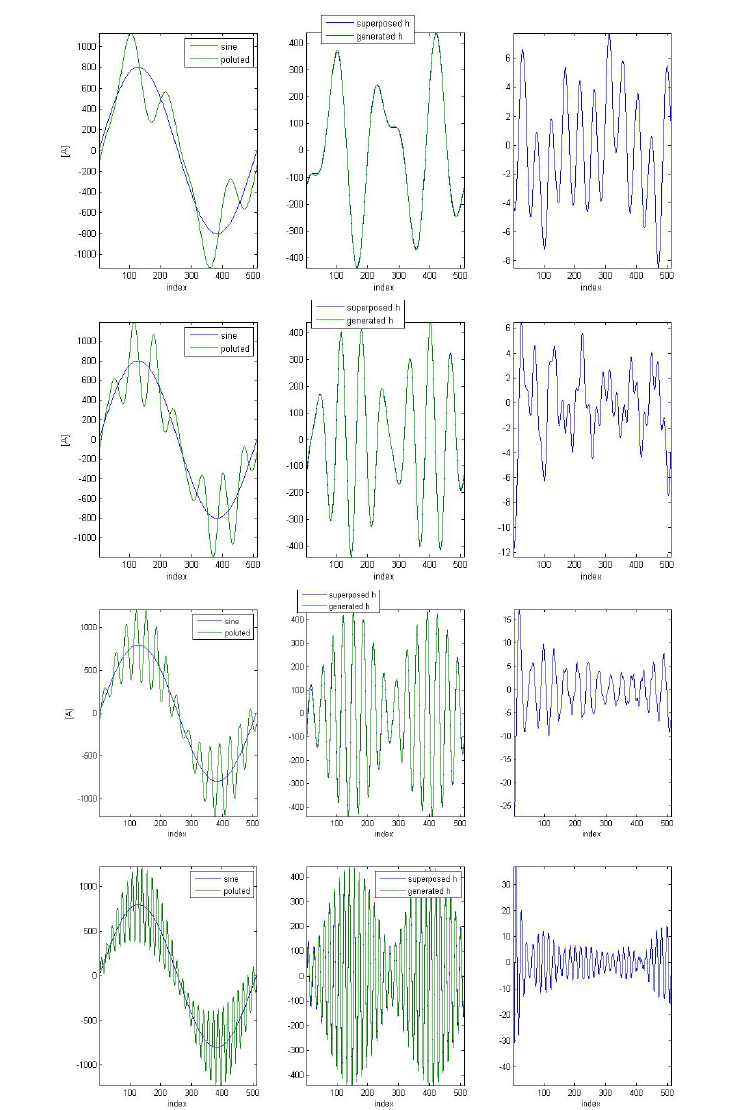
Figure 3. Results of decompositions / recompositions yielded by the optimized algorithm for synthetic signals. From top to bottom, 1-st CN7, 2-nd CN7, ..., 4-th CN7. From left to right: perfect sinusoid overlapped with the signal obtained from the superposition of the harmonics associated to the cluster, middle – generated and harmonic content reconstructed with WPT, right – di ff erence between the gen- erated and reconstructed harmonic